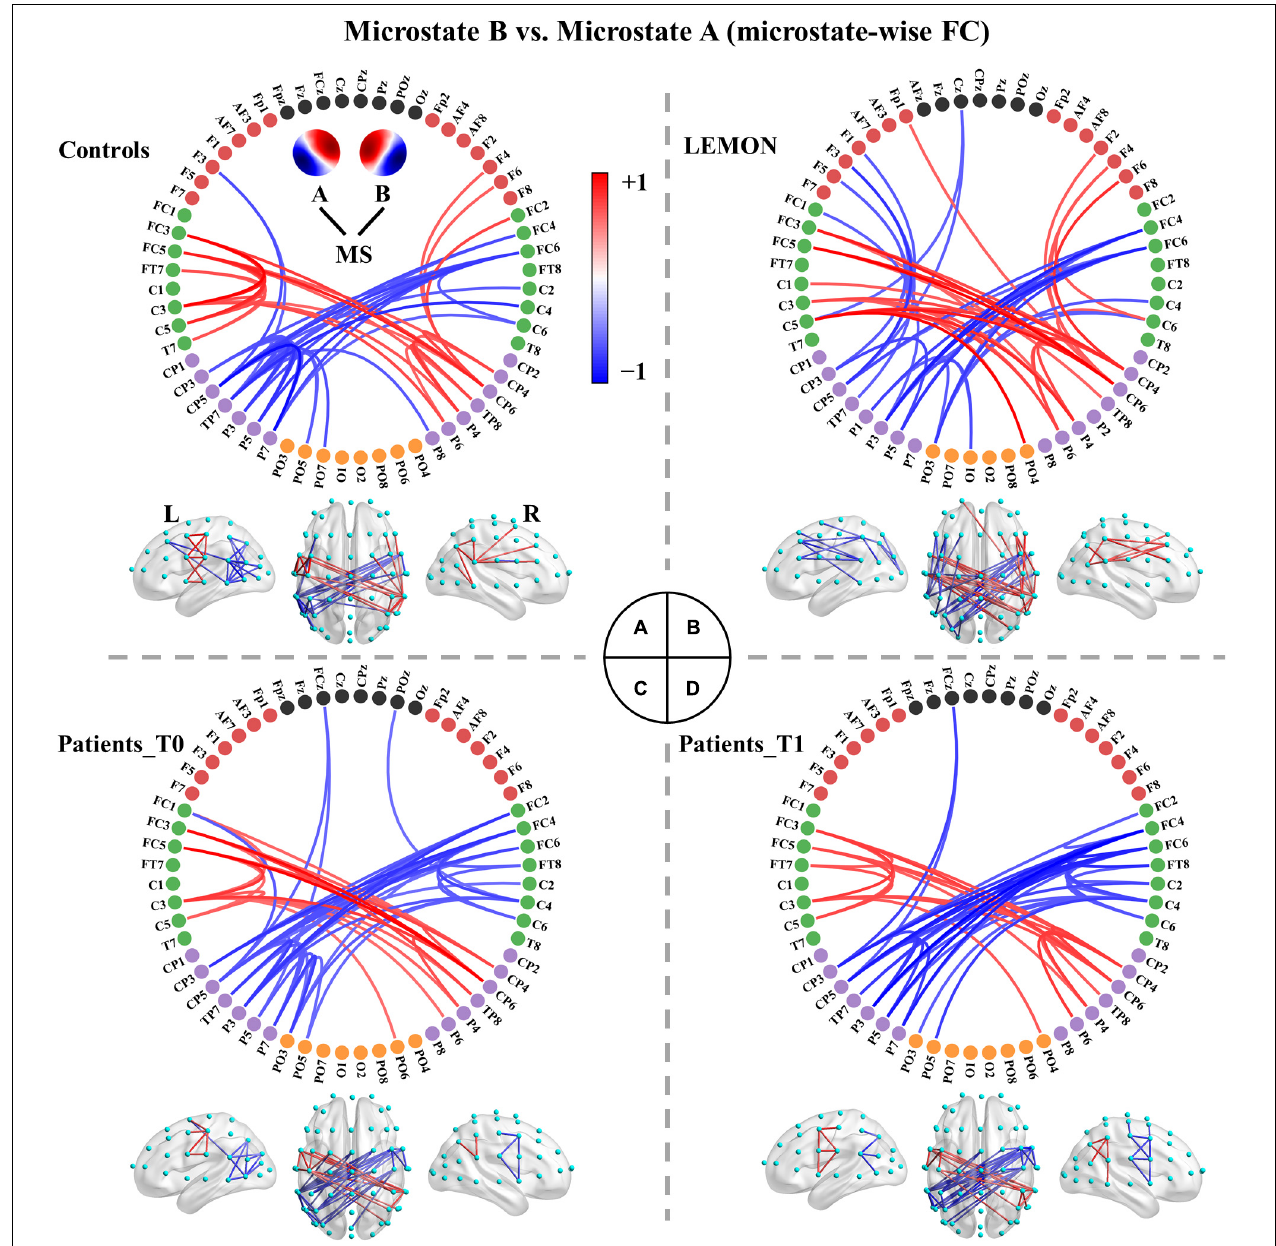
FIGURE 3 | Comparisons between functional connectivity of microstates A and B for the four groups. (A) Healthy controls. (B) LEMON. (C) Patients at T0. (D) Patients at T1. For visual clarity, only the top 50 connections (according to absolute t -values) in the connected components with significant differences ( p < 0.05, NBS-based method corrected) are displayed in the figure. The red color indicates greater connectivity for microstate B vs. microstate A, while the blue color indicates greater connectivity for microstate A vs. microstate B. Color depth represents the size of the connection difference ( t -value). The complete connected components are provided in the first column of Supplementary Figure 3